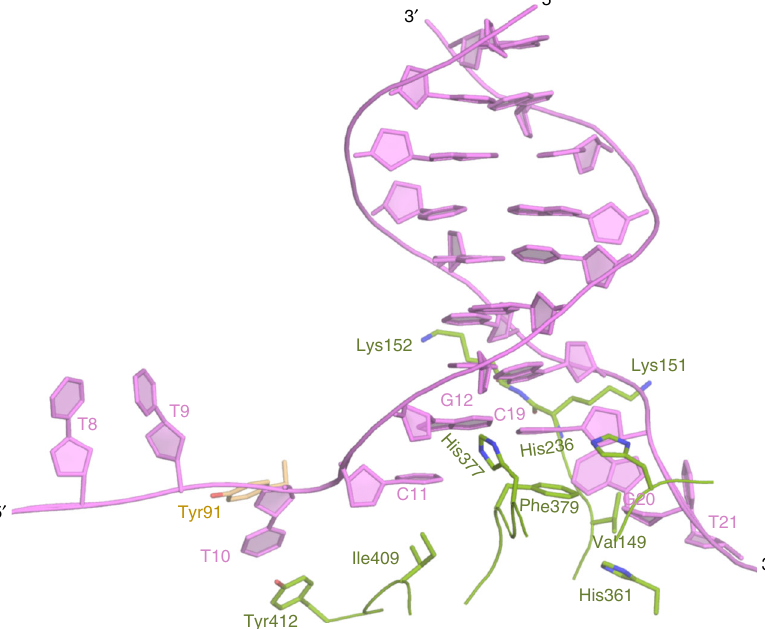
Fig. 2 Interaction of BaPif1 with forked dsDNA. Residue in brown belongs to BaPif1 A , residues in green belong to BaPif1 B and nucleotides of the forked dsDNA are in violet. Tyr91 A and Tyr412 B stack against T10. The fi rst base pair (C11 – G20) of the dsDNA is broken and C11 is stacked on one side by Ile409 B and on another side by the subsequent nucleotide G12. The other nucleotide, G20 of the broken base pair is stabilized by Val149 B and His361 B . The main chain of Lys151 B – Lys152 B anchor the phosphate backbone of the 3 ′ arm. A trio of residues, Phe379 B , His236 B and His377 B interact with the G12 – C19 base pair of the